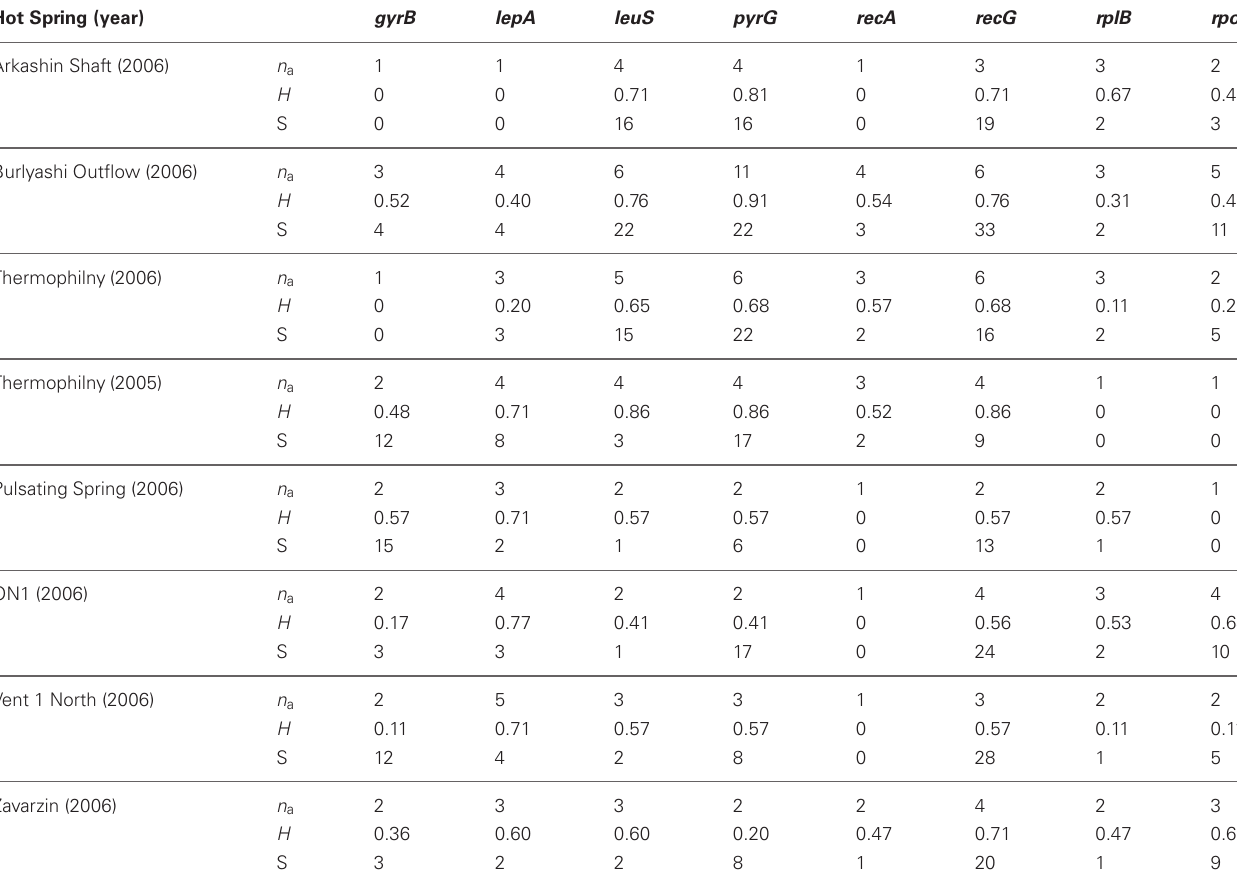
The eight isolates from Arkashin 2005 had the same genotype. Characteristics calculated for each protein coding locus were: number of alleles, n a ; genetic diversity, H; and number of polymorphic nucleotide sites,